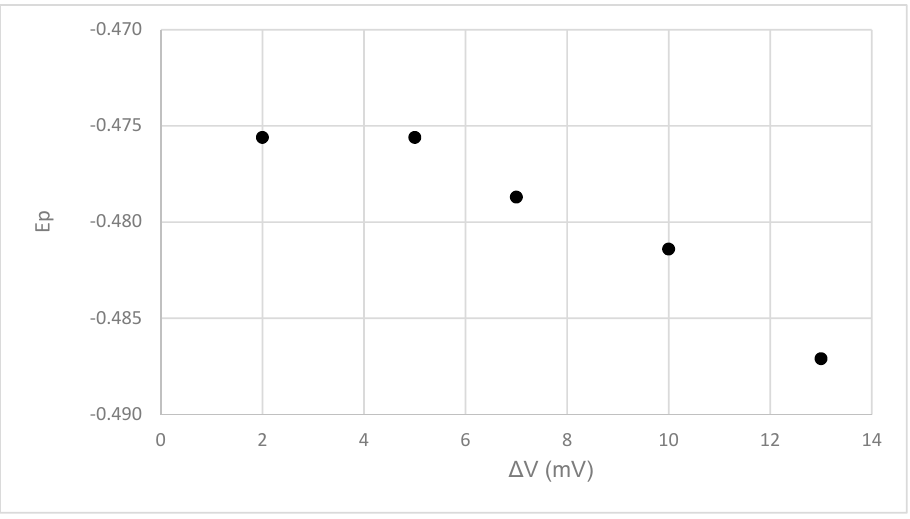
Figure 14. The influence of the DPP voltage increment ( Δ V) on the Ep value. The results are shown for Pahokee peat humic acid at 100 mg/L at a pH of 8 and in the presence of 1.0-M NaNO 3 . The Pb 2+ concentration was 4.8 uM.